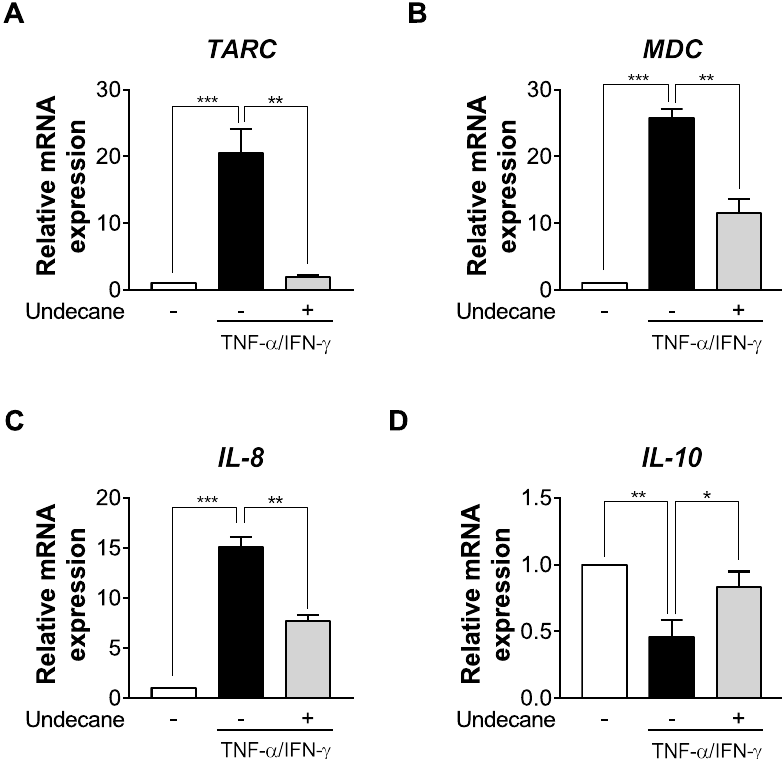
Figure 4. Effect of undecane on mRNA expression of inflammatory cytokines in HaCaT cells. After pretreatment (1 h) of vehicle (DMSO) or undecane (5 μM), the cells were incubated with